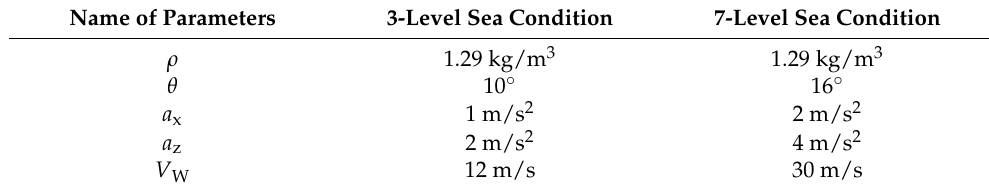
Table 2. Sea conditions table of the ship. Name of